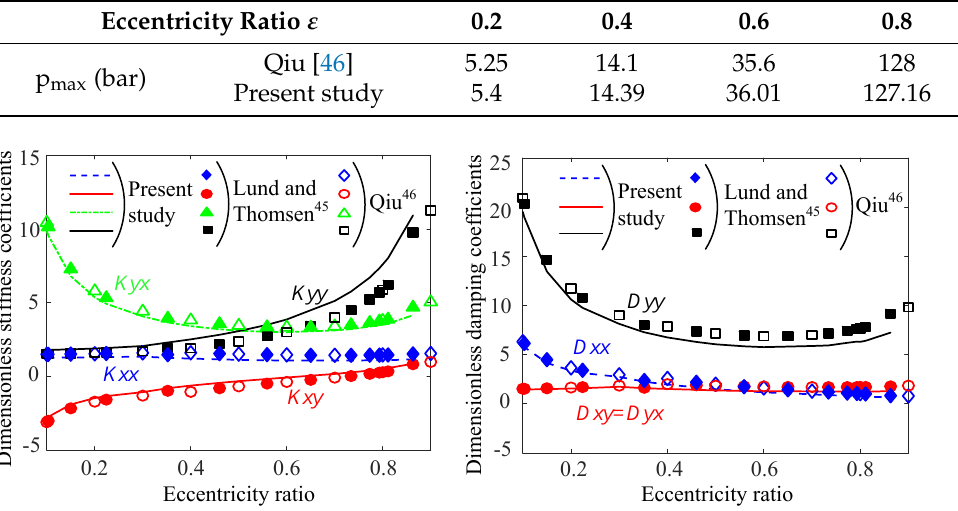
Figure 5. Dimensionless stiffness and damping coefficients and comparison with references [45,46].